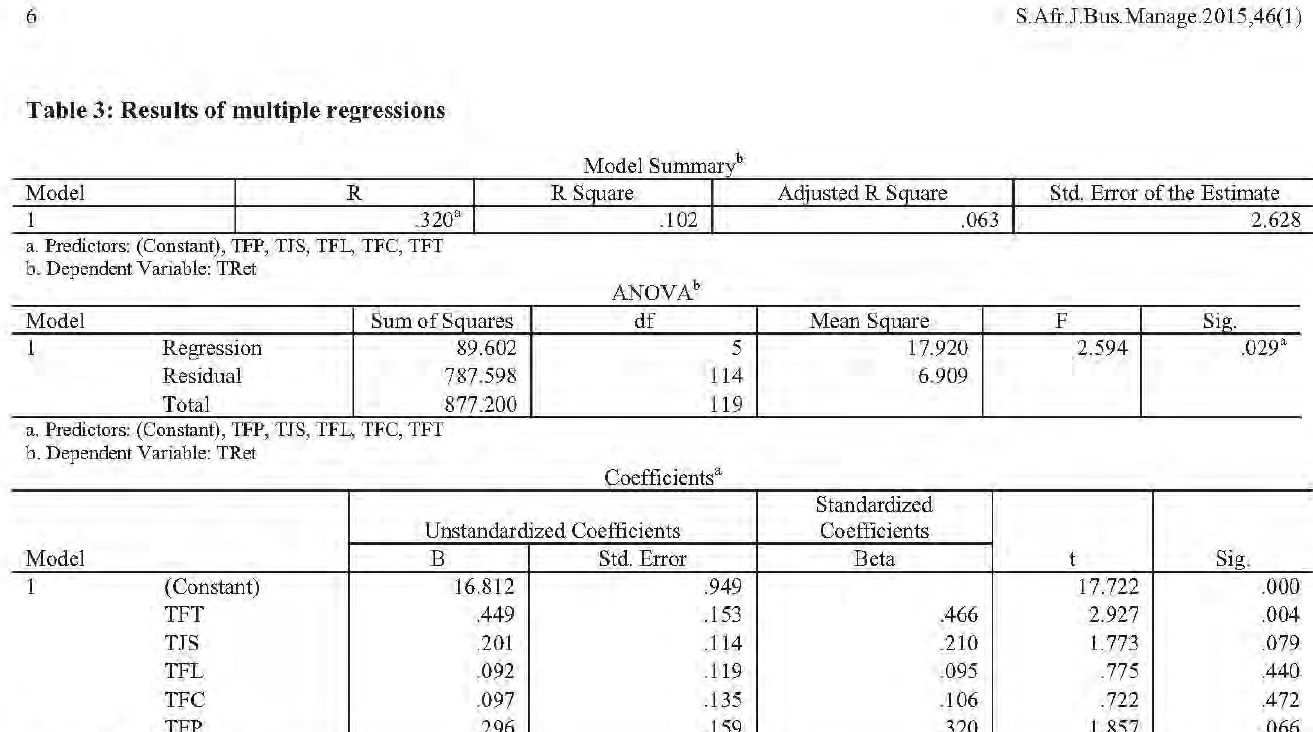
Table 3: Results of multiple regressions